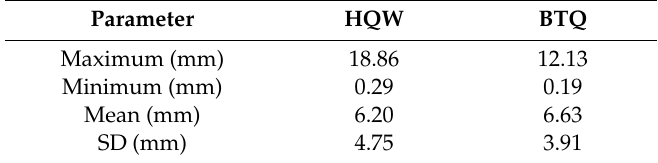
Table 5. Summary of depression storage in individual events in HQW and BTQ.